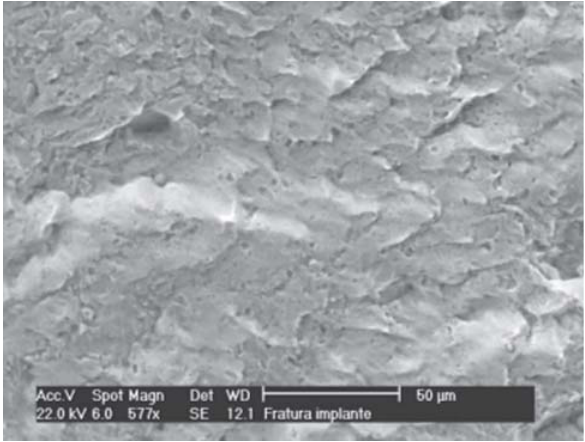
FIGURE 3 - Higher magnification of the first step, revealing wave-shaped irregularities, characteristic of fracture due to shear forces